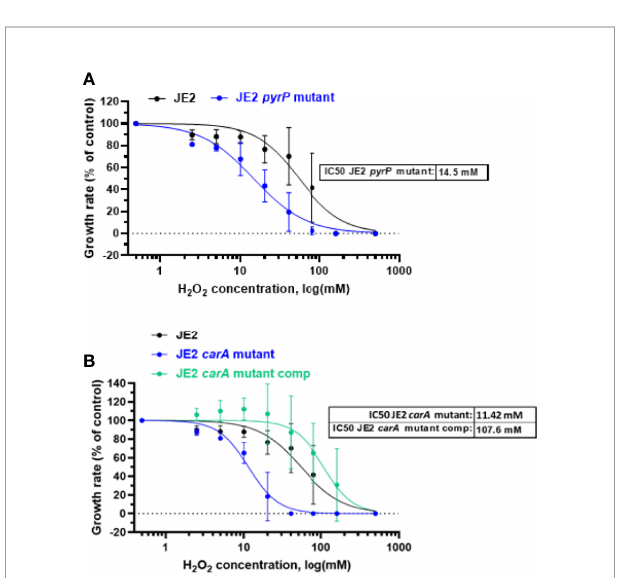
FIGURE 5 | H 2 O 2 effect on bacterial growth rate. Growth of wild-type S. aureus JE2 strains and pyrP (A) and carA mutants and carA mutant carrying a multicopy plasmid expressing carA (JE2 carA mutant comp) (B) was analysed in the presence of 8 different concentrations of H 2 O 2 and compared to growth in the absence of H 2 O 2 . Normalized values were expressed as percent of growth in the absence of H 2 O 2 on the same experiment. Results represent the mean ± SD of two independent experiments (four replicates for each H 2 O 2 concentration). A nonlinear regression model was made to estimate the IC 50 . p >